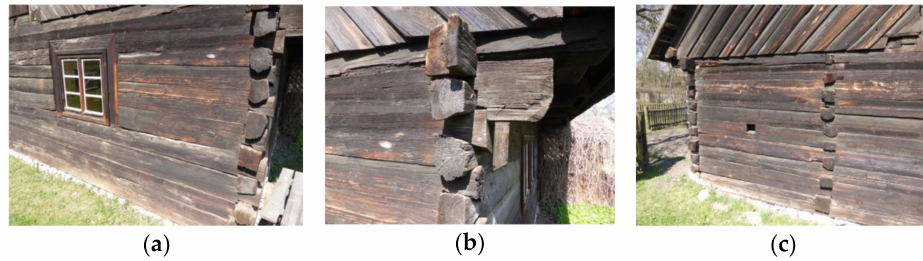
Figure 20. Wall beam connections in traditional construction: ( a ) north site, ( b ) south site, ( c ) east site.